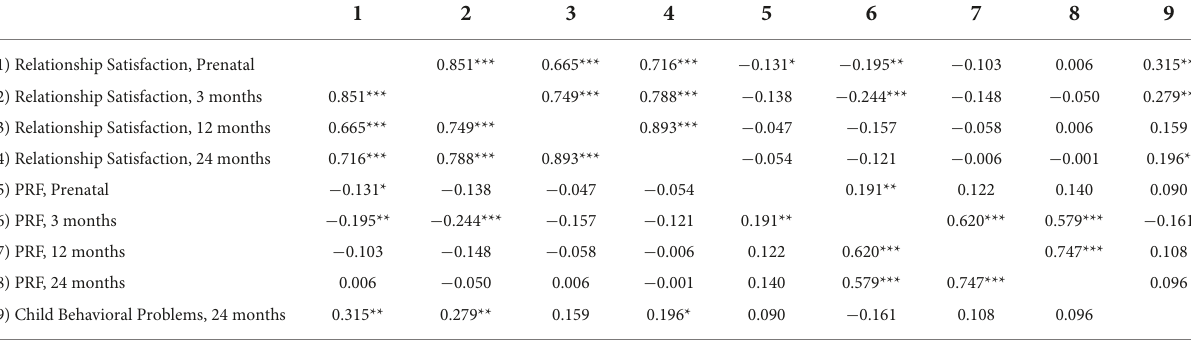
TABLE 6 Correlations between the study variables for fathers.